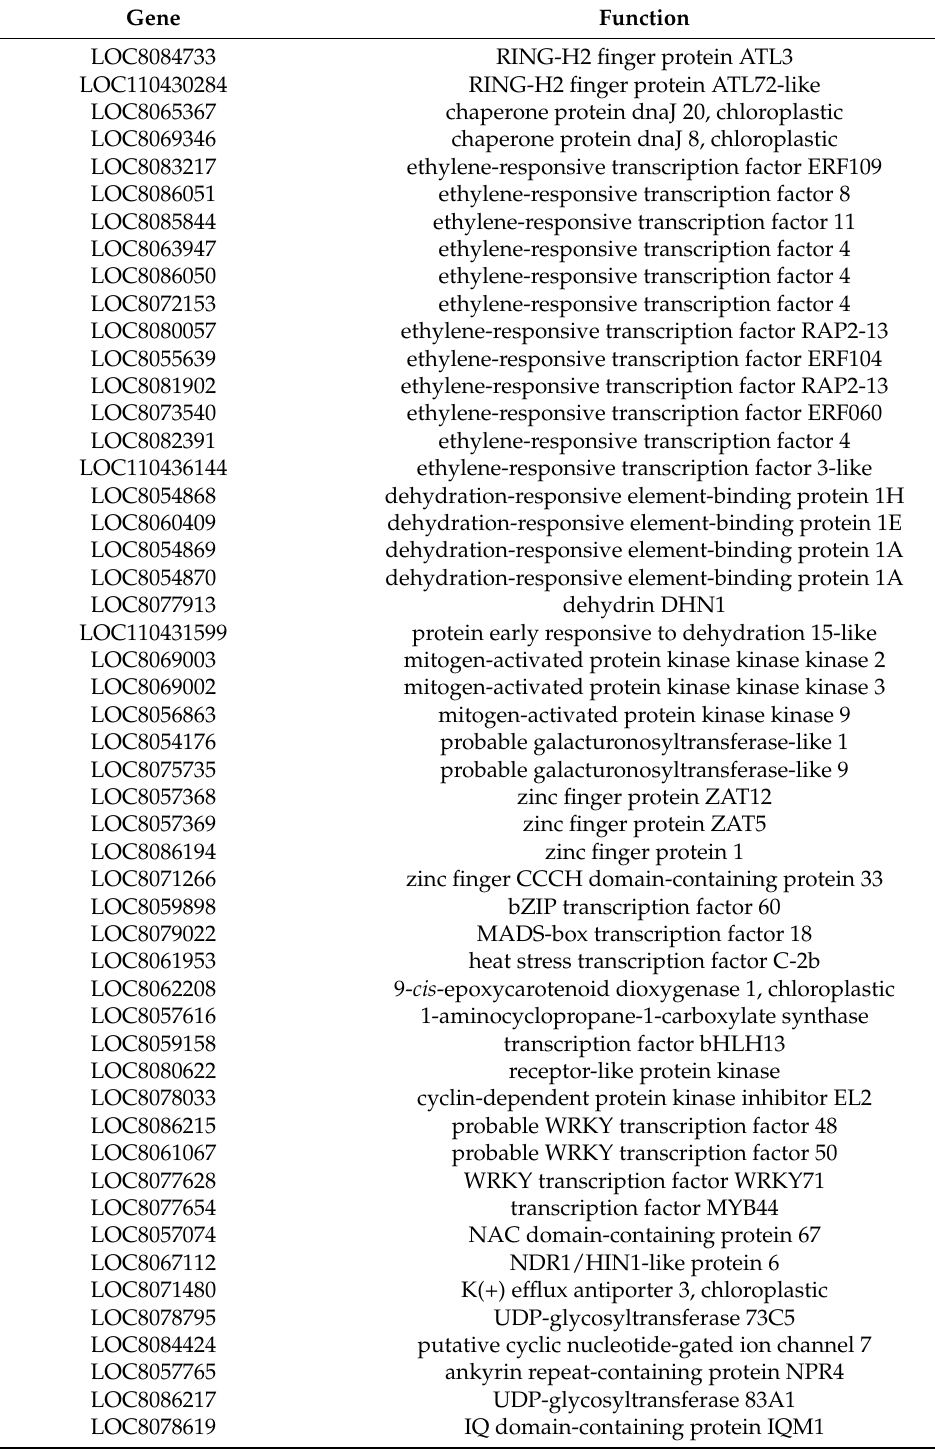
Table 1. List of genes related to abiotic stress among commonly up-regulated genes in leaves and roots under the salt